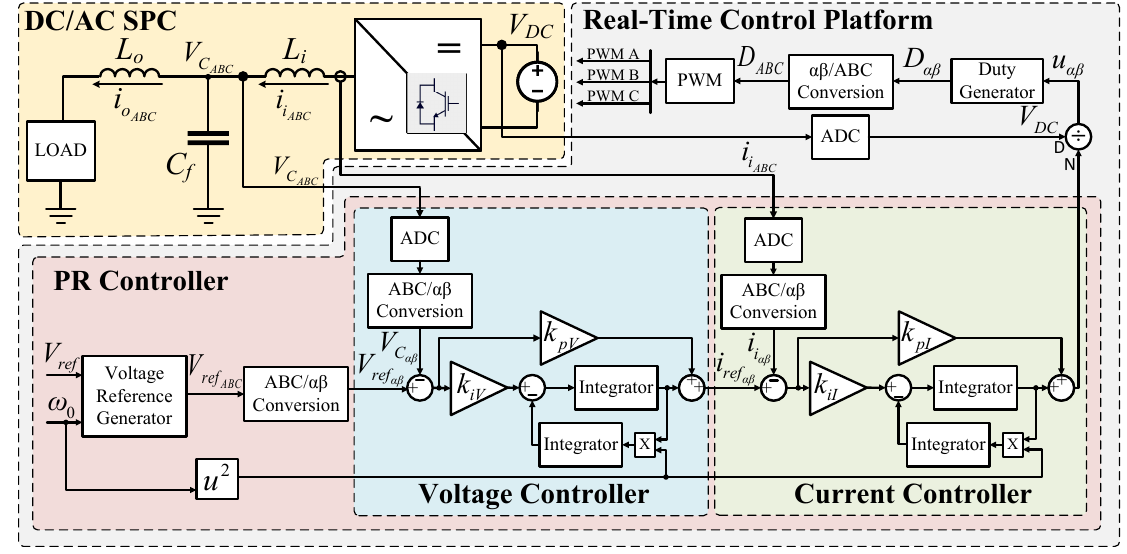
Figure 5. General structure of the PR controller for DC/AC